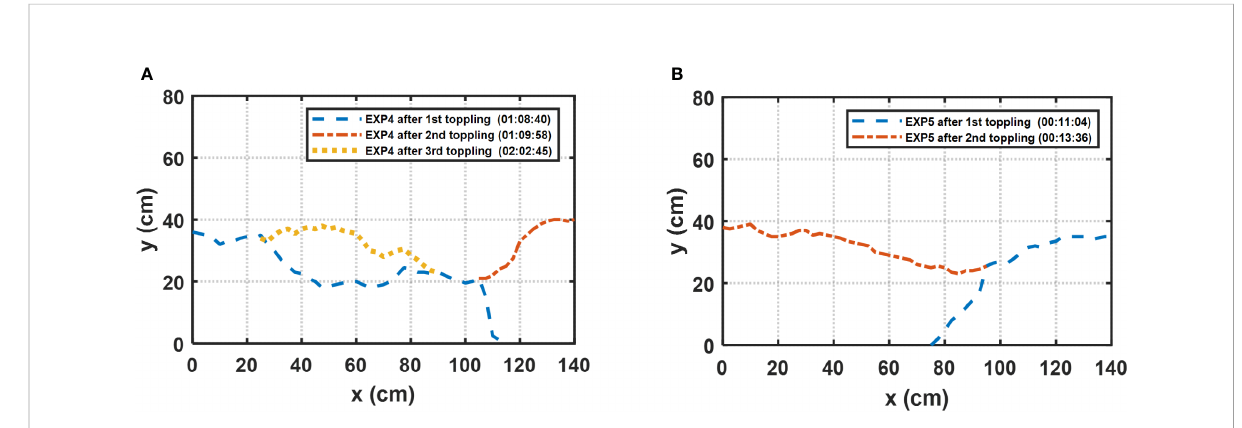
FIGURE 5 Bank line evolution of experiments extracted from Figure 4: (A) EXP 4; (B) EXP 5. The x and y directions are consistent with those in Figure